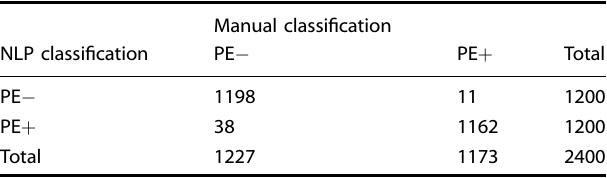
Fig. 4 PE positivity and prevalence. Adjusted odds ratios for PE positivity ( a ), with the pre-COVID-19 period as the reference standard, and adjusted marginal estimate for PE prevalence by each site as well as combined ( b ). The sizes of the bubbles are proportional to 1/SE of the % estimates. Table 3. A natural language processing (NLP) validation trial using a manual review of 2400 radiology reports was conducted at 12 participating